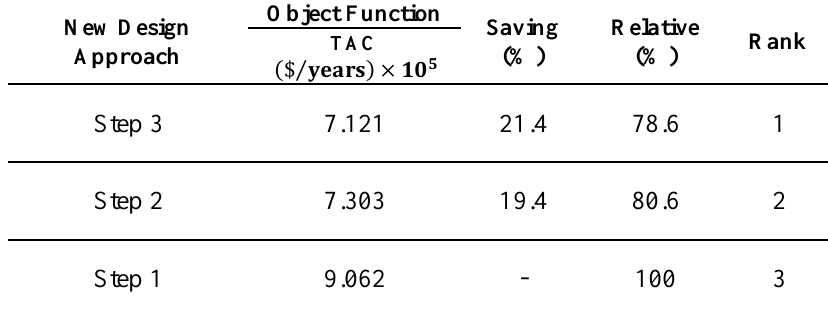
Table 13. Comparing the performance of designed column sequences with economic